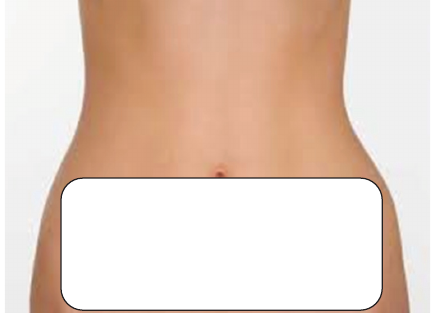
Figure 2: Marked area for